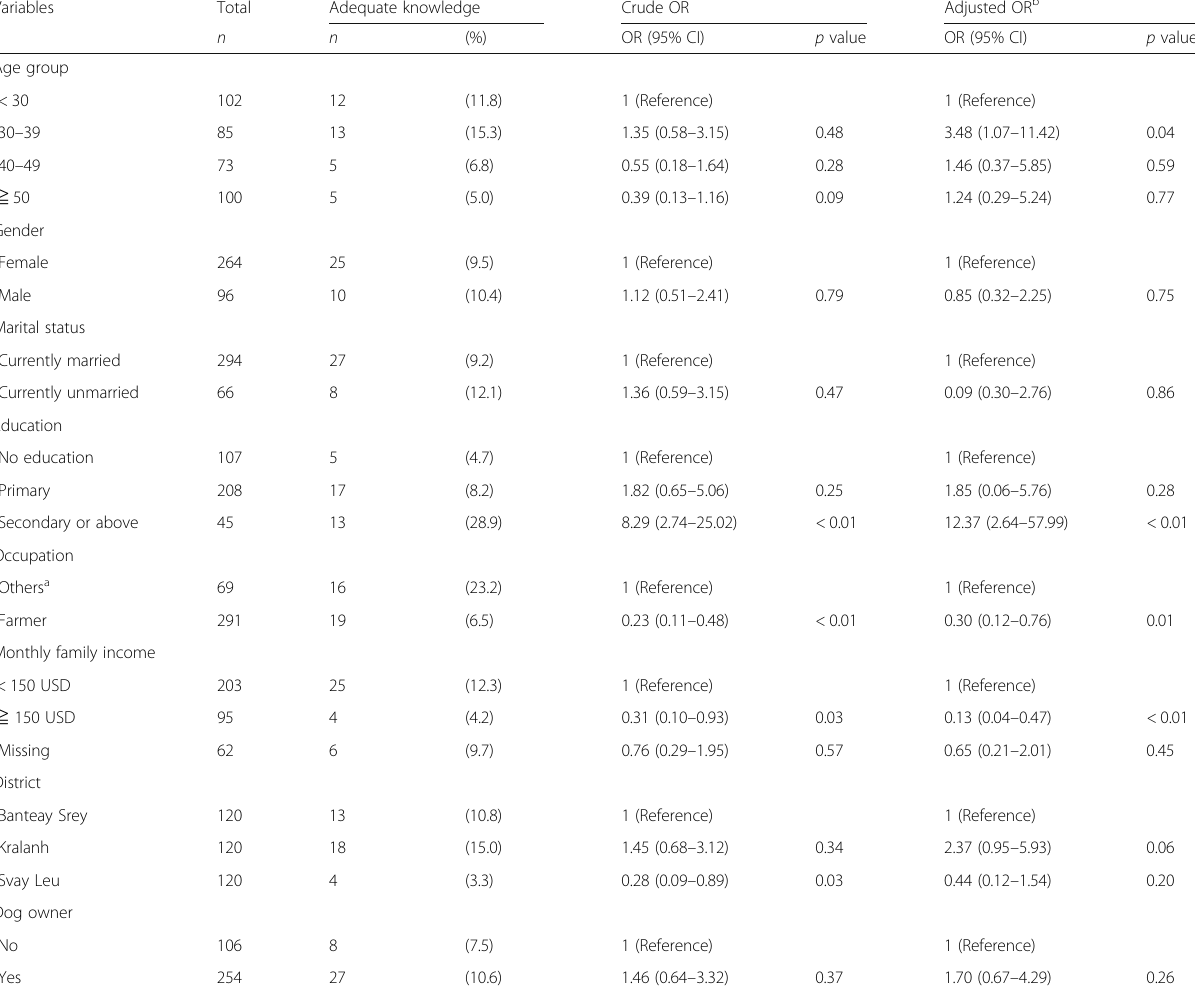
Table 6 Crude and adjusted OR of adequate knowledge for respondents ’ characteristics ( n = 360) Variables Total Adequate